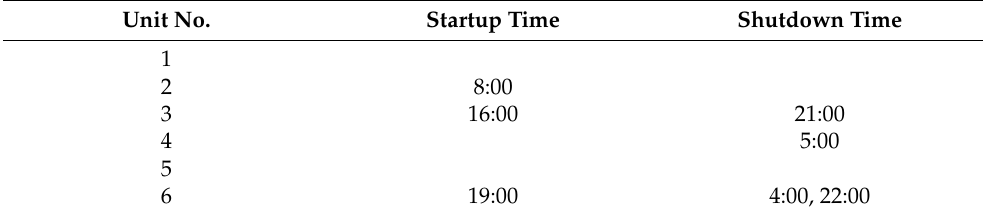
Figure 3. Outputs of thermal units at each period. Table 3. Unit startup/shutdown status within the simulation